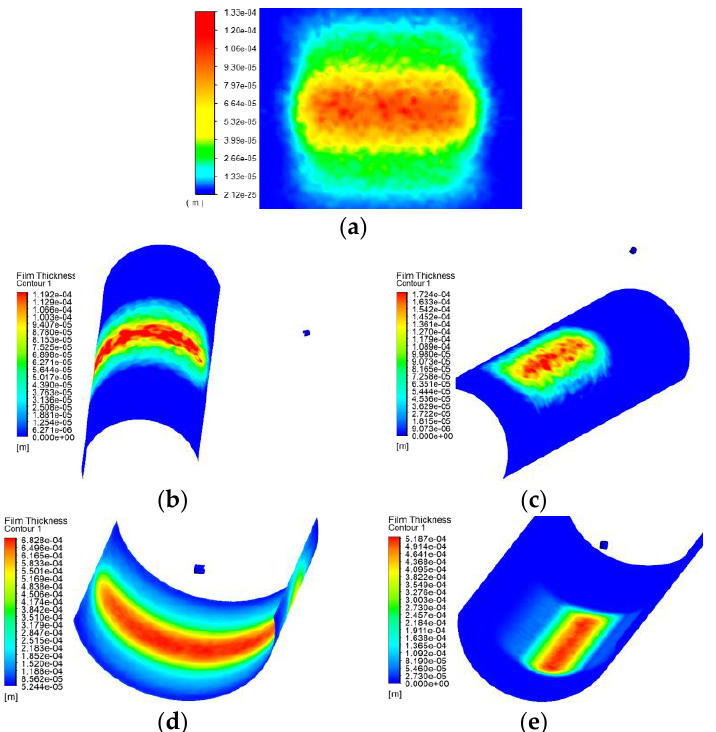
Figure 16. Coating film distributions of the dynamic spraying. ( a ) Plane spraying. ( b ) Outer surface busbar spraying. ( c ) Circumferential spraying on the outer surface. ( d ) Inner surface busbar spray- ing. ( e ) Circumferential spraying on the inner surface.